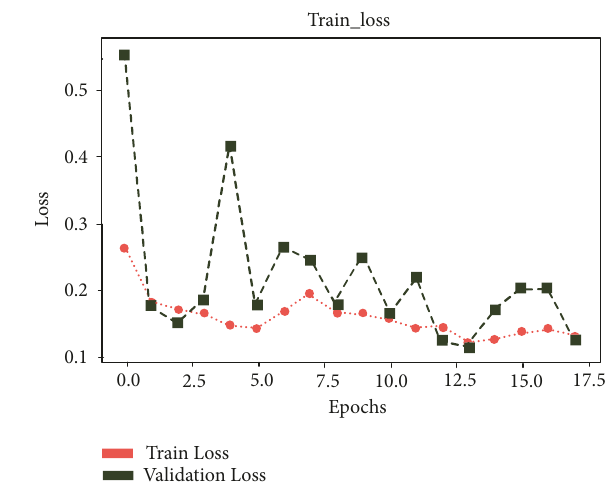
Figure 5: F-beta score and categorical accuracy GRU.